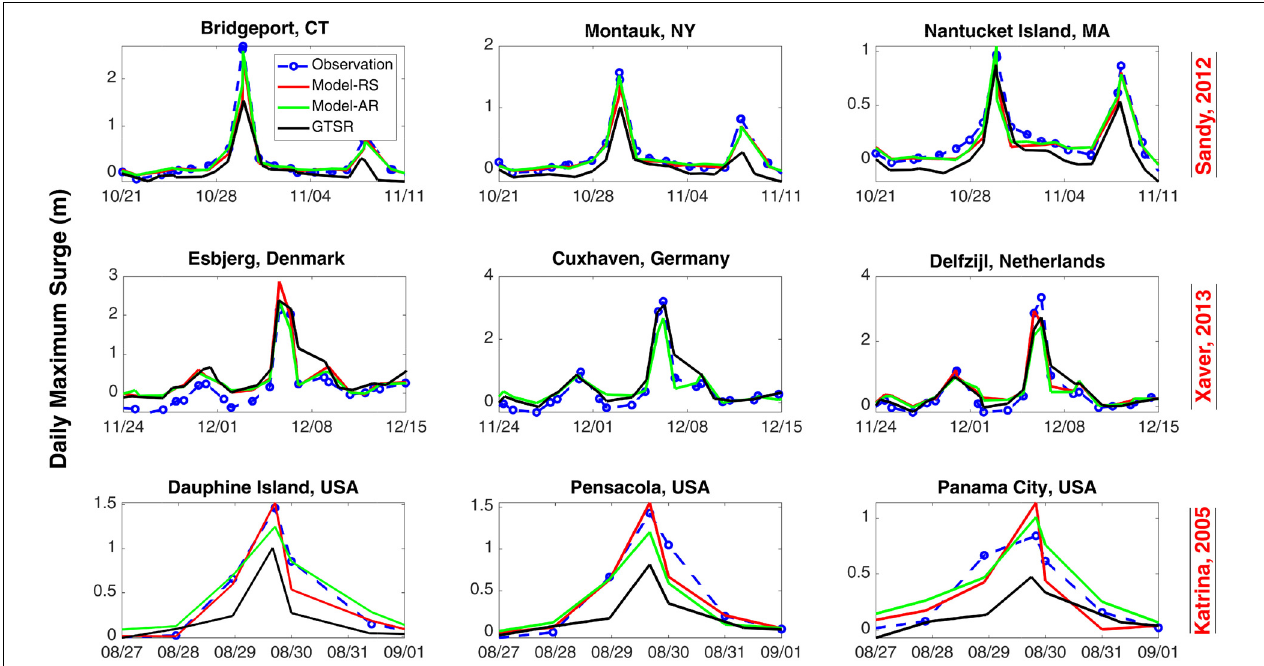
FIGURE 14 | Validation of Model-RS, Model-AR, and GTSR for individual storm events: Superstorm Sandy (top), Cyclone Xaver (middle), and Hurricane Katrina